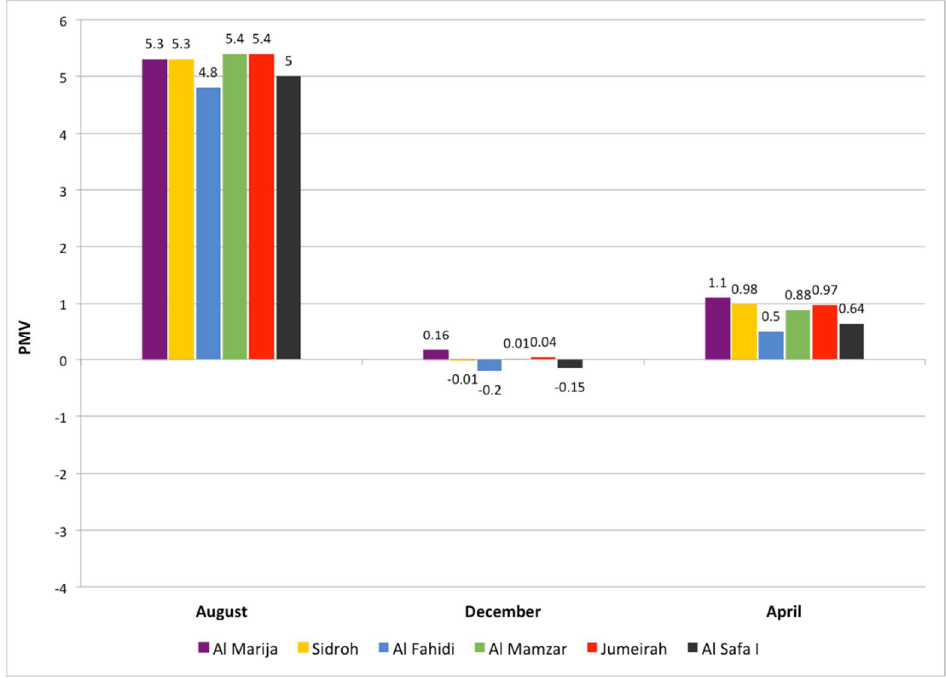
Figure 24. PMV average values for Al Marija, Sidroh, Al Fahidi, Al Mamzar, Jumeirah, and Al Safa I during the three different seasons. Table 8. ENVI-met maps of the PMV values for Al Marija, Sidroh, Al Fahidi, Al Mamzar, Jumeirah, and Al Safa I in August at 2:00 pm (Images generated by ENVI-met).